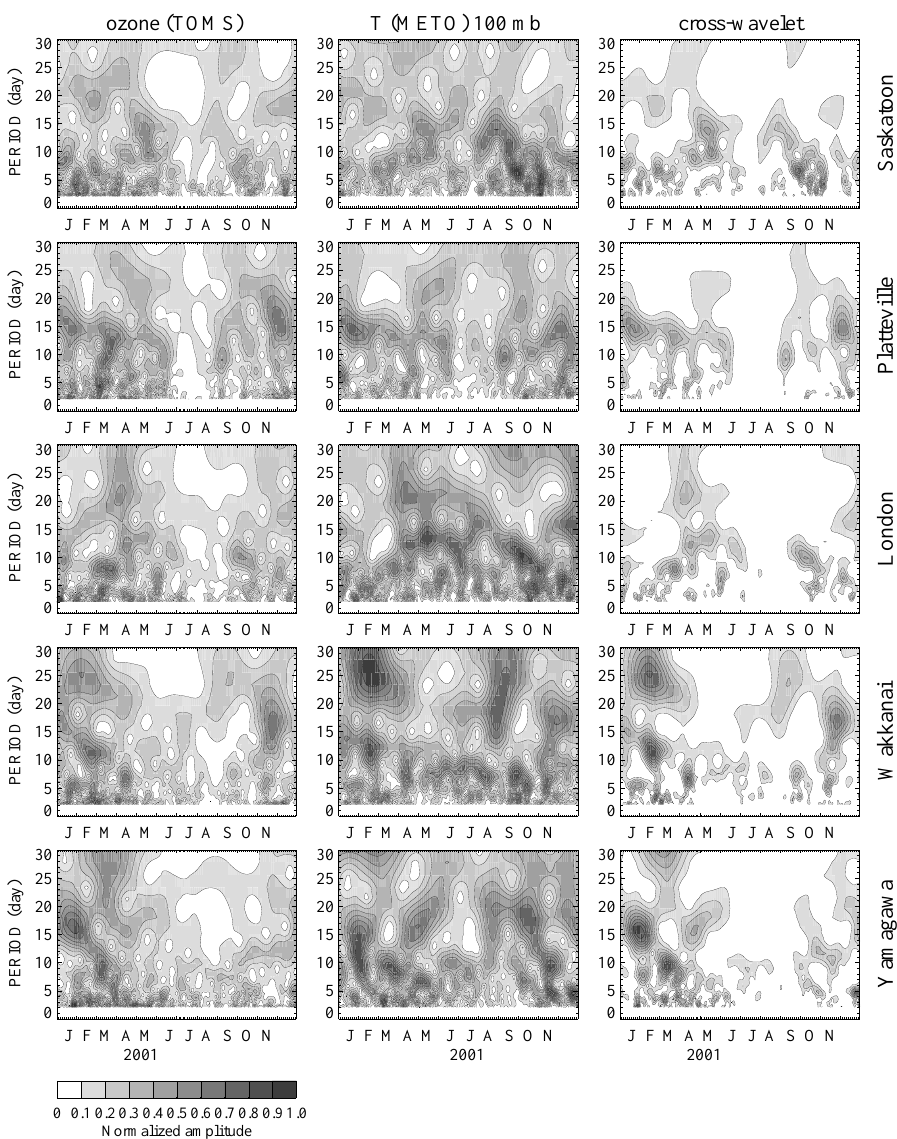
Fig. 4. The self-normalized wavelet amplitudes versus time (2001 year) and period (2–30 days) calculated for the total ozone (the left column) and MetO temperature at 100mbar (the center column), and their cross-products (the right column) are presented for all five CUJO locations. From the top to the bottom these are for Saskatoon, Platteville, London, Wakkanai, and